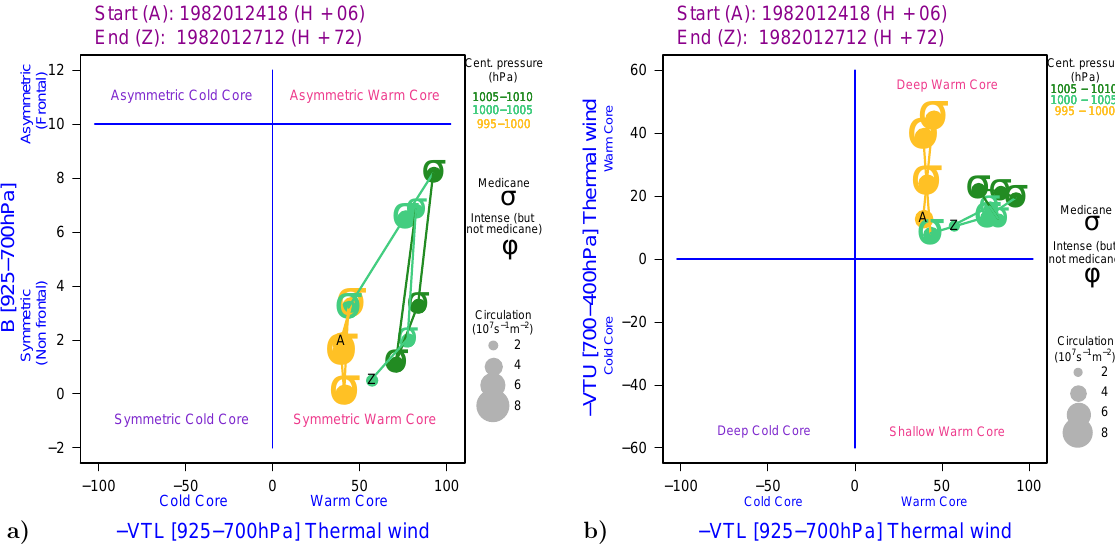
Fig. 3. Cyclone phase diagrams I (a) and II (b) , for January 1982 event. Circle colour refers to central pressure value and circle size is related to geostrophic circulation value. Symbol σ indicates the presence of